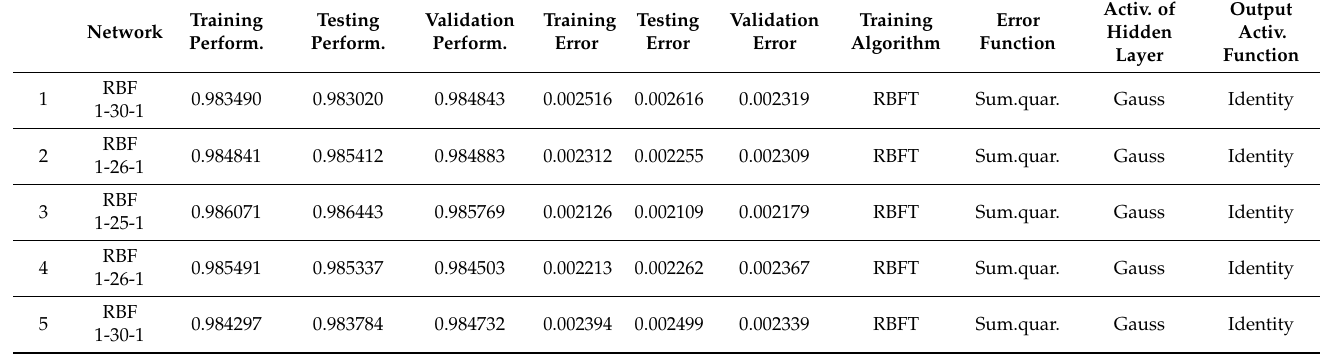
Table 2. Retained neural